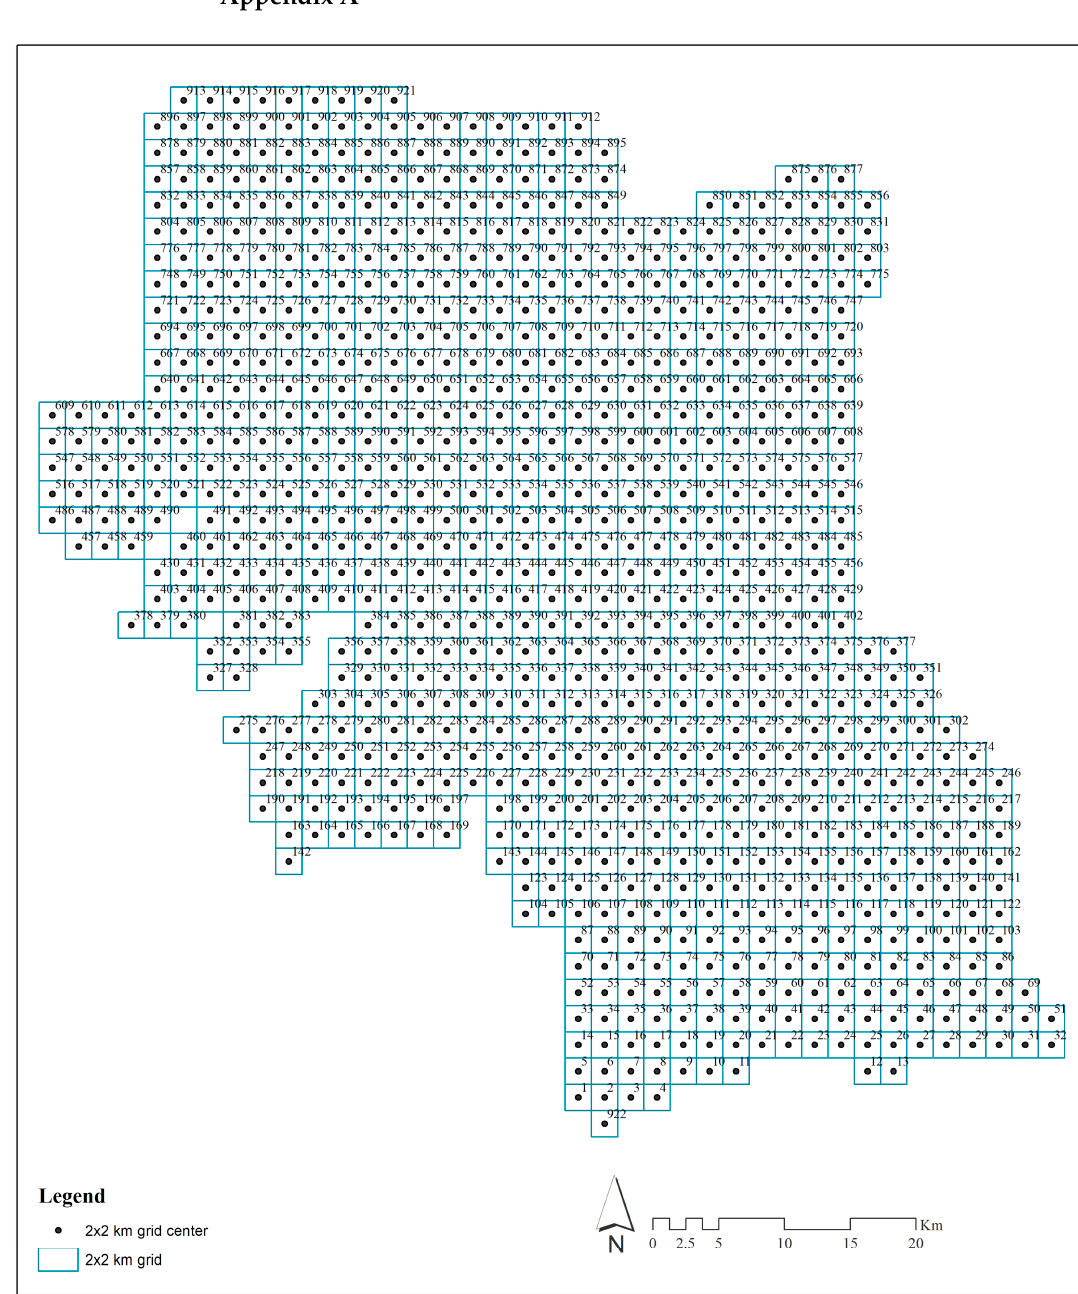
Figure A1. Grid Numbers.